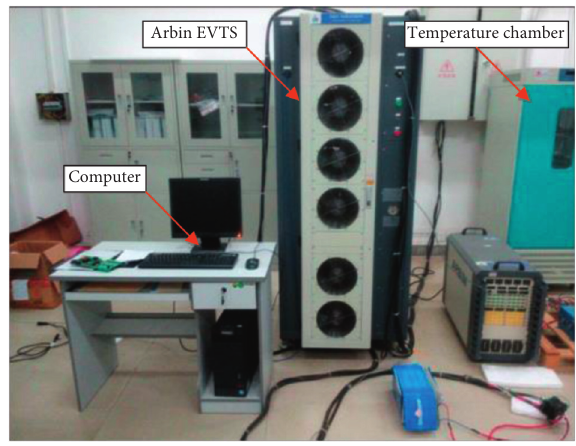
Figure 5: Battery test